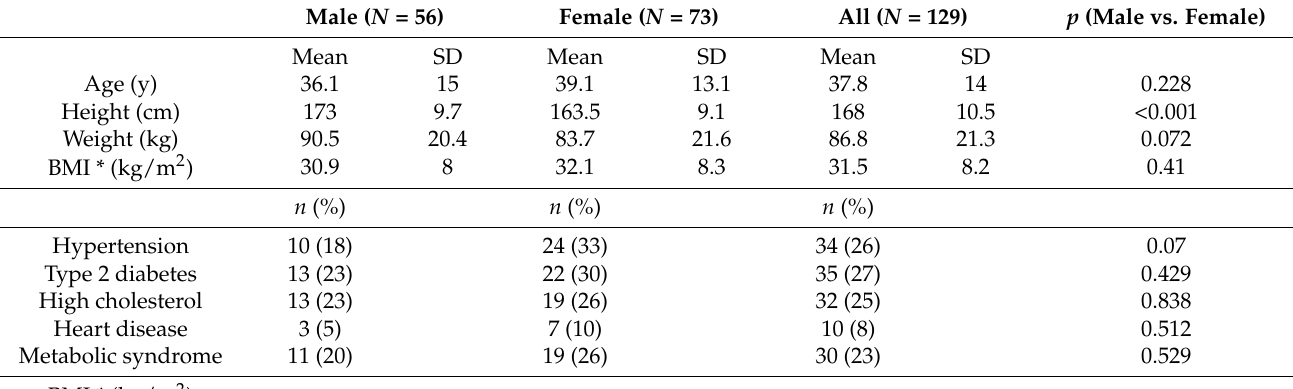
Table 1. Clinical characteristics of the participants.